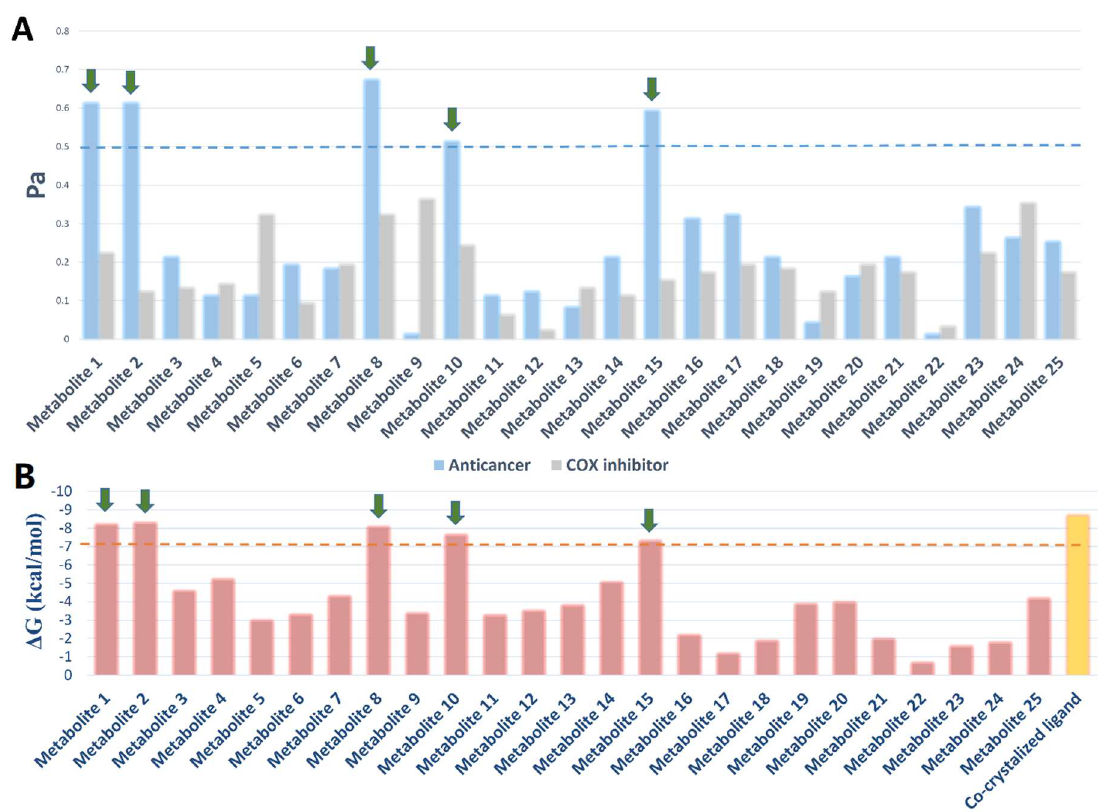
Figure 7. PASS prediction scores of the compounds 1–25 as anticancer agents and COX inhibitors ( A ). Pa > 0.5 indicates high probability of them being active in vitro. Binding energy scores of compounds 1–25 inside sPLA2 ( B